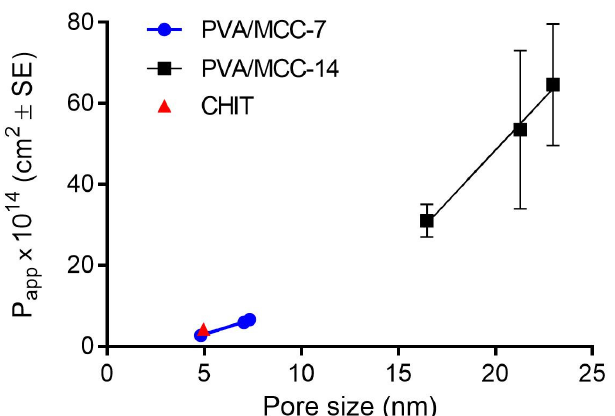
Figure 8. Correlation of the permeability coefficient as a function of the pore size for the hydrogels under study. For some points, the error bar is shorter than the height of the symbol.